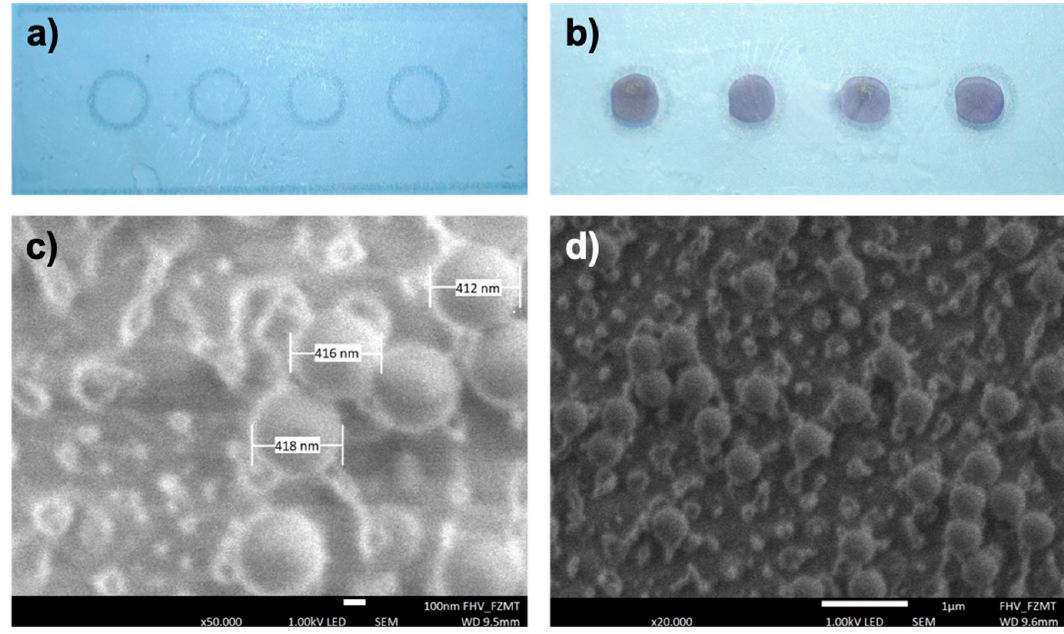
Figure 7. Photo of an ( a ) untreated and ( b ) a plasma activated PMMA foil after the linker-free immobilization of 400 nm bead labelled antibodies. SEM images of a single immobilization area with two different magnifications: ( c ) 50,000× and ( d ) 20,000×. The latex beads can be clearly seen in both SEM pictures and their measured diameter is around 414 nm. For the antibody density estimation, the latex beads in ( d ) are counted and extrapolated to the whole immobilization area.